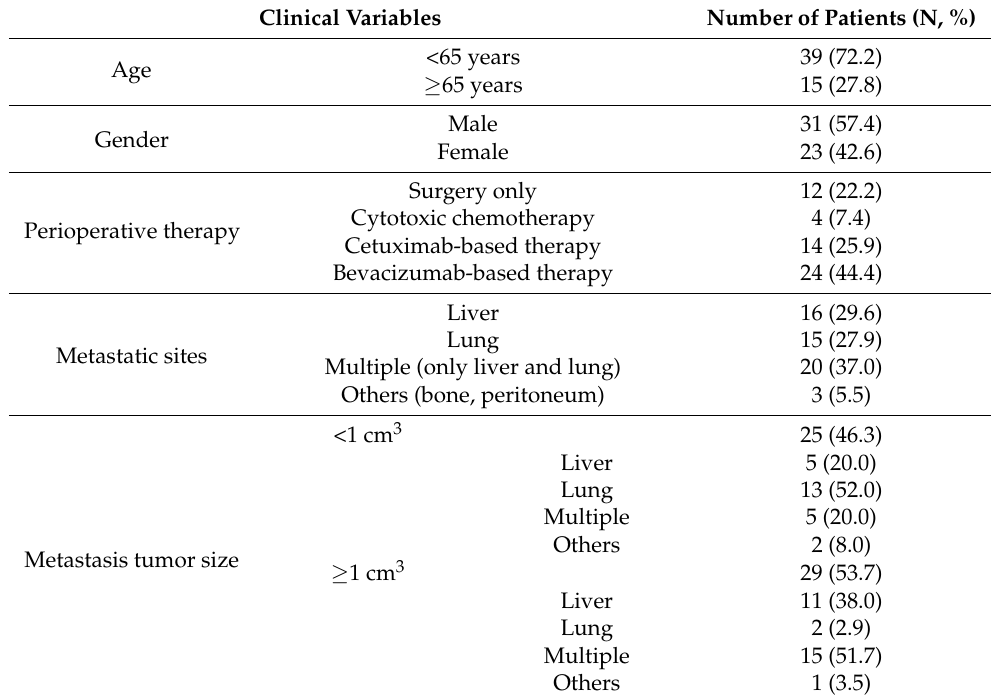
Table 1. Baseline